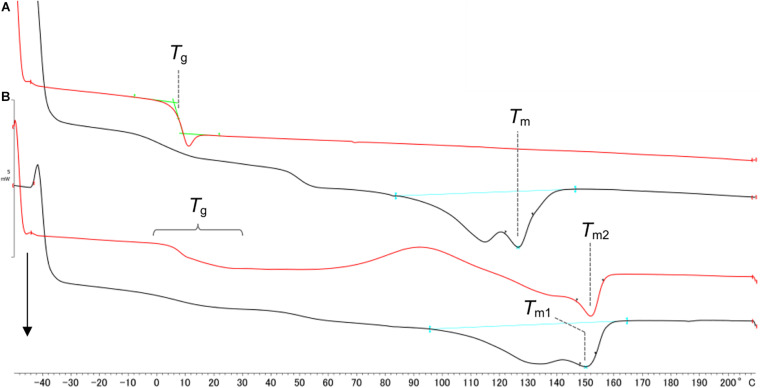
DSC analysis of P(GL-co-3HB)s synthesized by PhaC1PsSTQK (A) and PhaCAR
(B). The black line indicates the 1st heating scan. The red line indicates the 2nd heating scan. The arrow indicates endothermic reactions. (A)
Tm = 126.3°C, ΔHm = 23.0 J/g and Tg = 7.6°C. (B)
Tm1 = 151.4°C, ΔHm = 34.6 J/g (1st heating scan), and Tm2 = 151.6°C (2nd heating scan). 3HB was supplemented at 12 h to produce a polymer by PhaCAR.